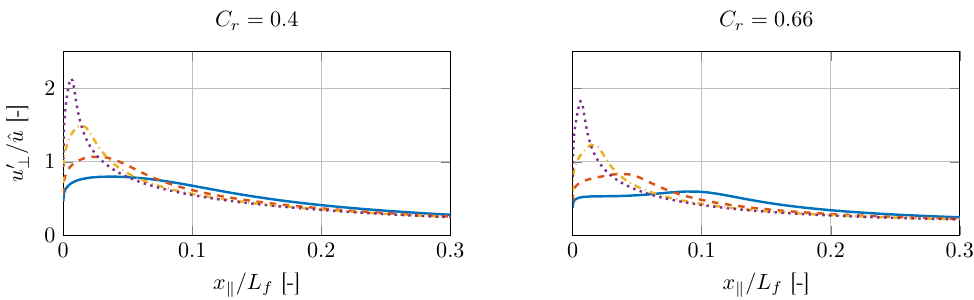
Figure 9. Flame normal velocity perturbation along the flame length resulting from Kutta conditions with panel lengths H ξ ( ), H ξ /2 ( ), H ξ /4 ( ) and H ξ /8 ( ). H ξ is set to 2.1 for C r = 0.4 (c.f. Figure 4) and to 1.8 for C r = 0.66, respectively.